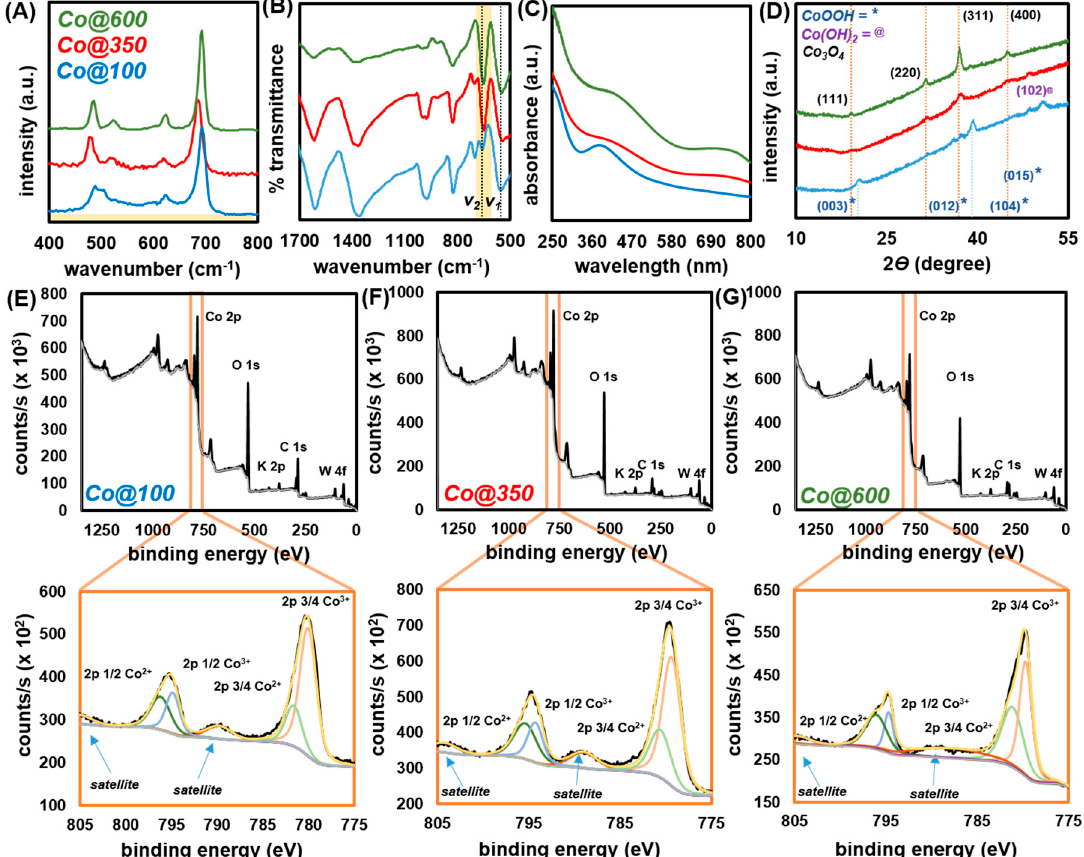
Figure 4. Raman ( A ), FTIR ( B ), UV-Vis ( C ), and XRD ( D ) spectra of Co@100, Co@350 and Co@600. (a.u. = arbitrary units). XPS survey and close-up of Co 2p region for ( E ) Co@100, ( F ) Co@350, and ( G ) Co@600.